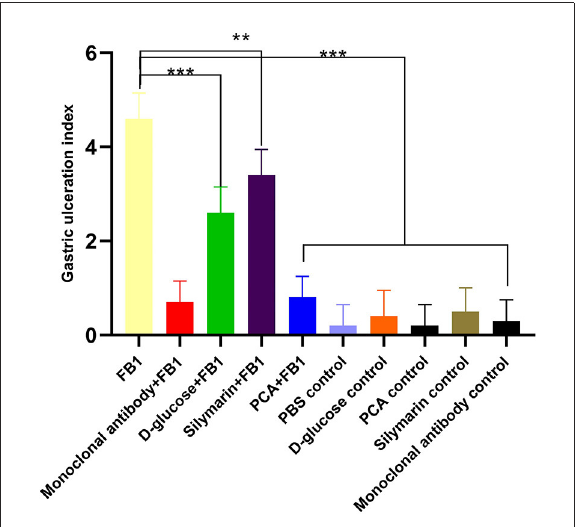
FIGURE5 Gizzard ulceration index of chickens post inoculation with FB1 in different experimental groups. Postmortem, higher gizzard ulceration index was determined in the FB1 group, the D-glucose + FB1 group, and the silymarin + FB1 group compared to those of other groups. Compared to the D-glucose + FB1 group, both the PCA + FB1 group and the monoclonal antibody + FB1 group induced lower gizzard ulcerations ( p < 0.01). The data were expressed as mean ± SD. ** p < 0.01 and *** p <